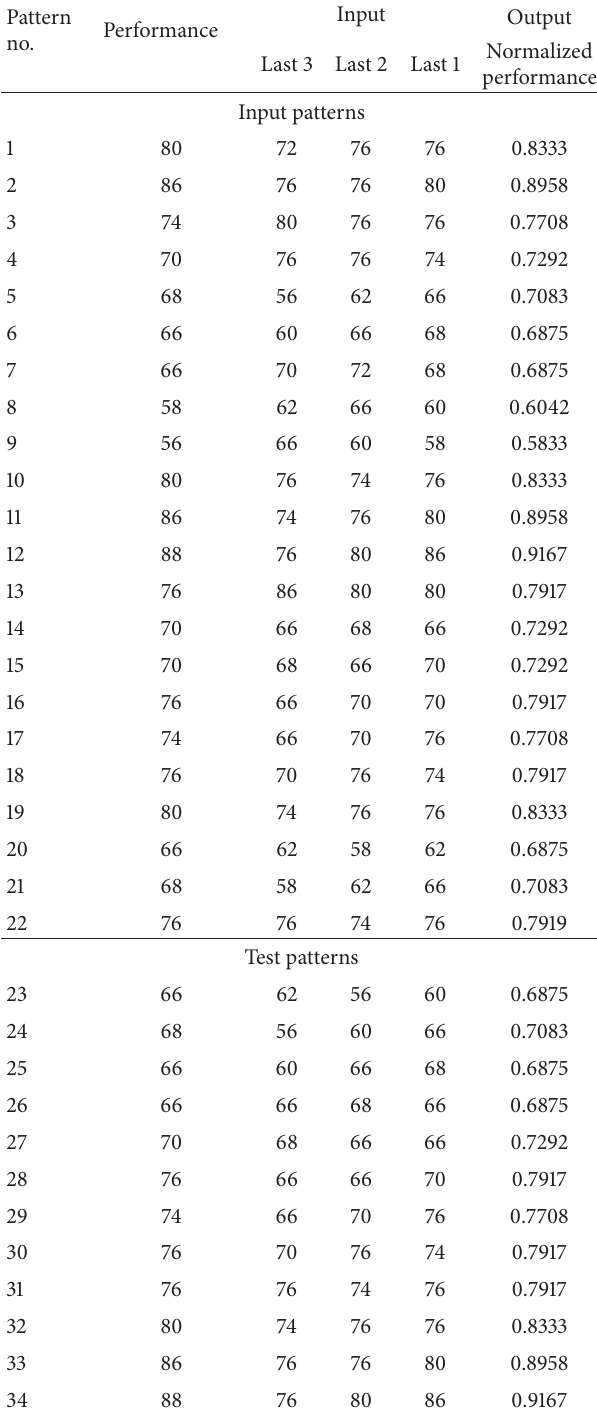
Table 1: Subcontractor performance historical records. Pattern